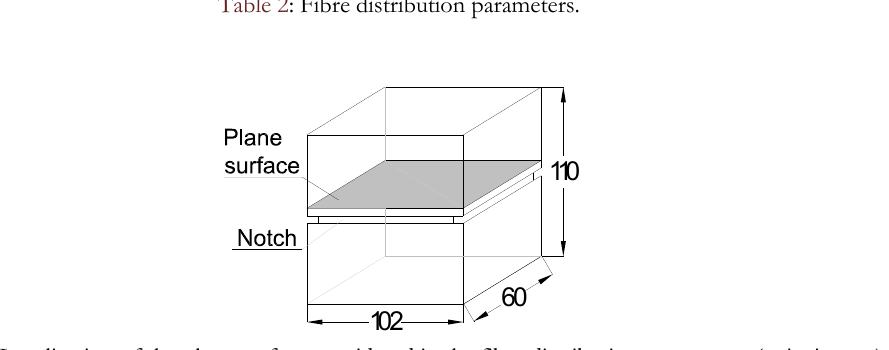
Figure 8: Localization of the plane surface considered in the fibre distribution assessment (units in